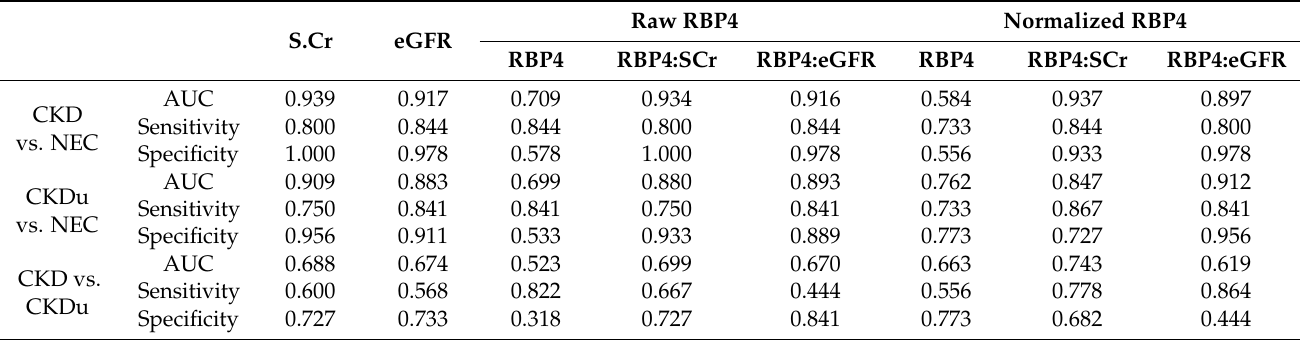
Figure 6. Ratio index as discriminatory marker between the 2 CKD diseases using normalized RBP4 values. ROCs showing performance of RBP4:S.Cr ( A ) and RBP4:eGFR ratios ( C ) as discriminatory markers for CKD and CKDu. Distribution of RBP4:S.Cr ( B ) and RBP4:eGFR ratios ( D ) in CKD (blue) and CKDu (red). Normalized values of RBP4 are used. Table 2. Overview of performances of the associated